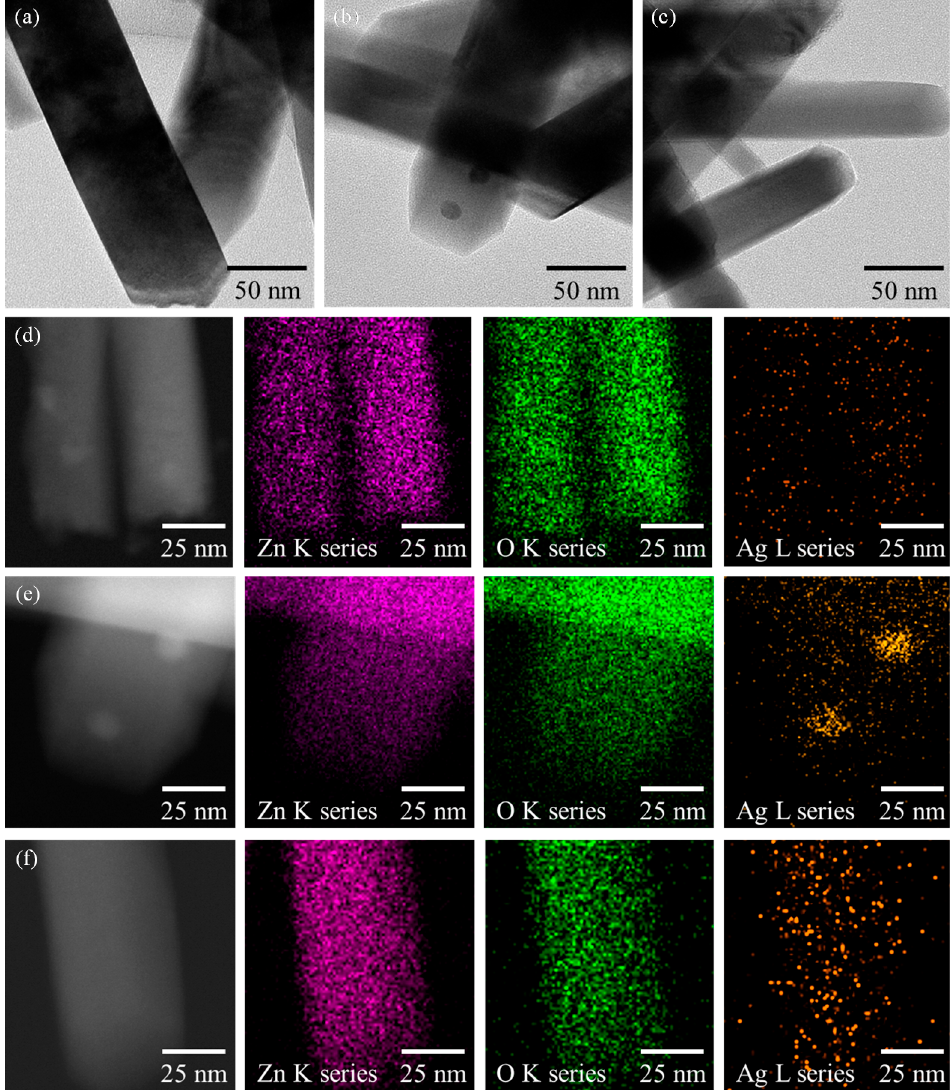
Figure 3. TEM images of ( a ) the as-grown ZnO NWs and the Ag-decorated ZnO NWs processed at IPL energy of 1 J/cm 2 and AgNO 3 concentration of ( b ) 100 nM, and ( c ) 1 mM. Elemental map image of ( d ) the as-grown ZnO NWs and the Ag-decorated ZnO NWs at IPL energy of 1 J/cm 2 and AgNO 3 concentration of ( e ) 100 nM, and ( f ) 1 mM.